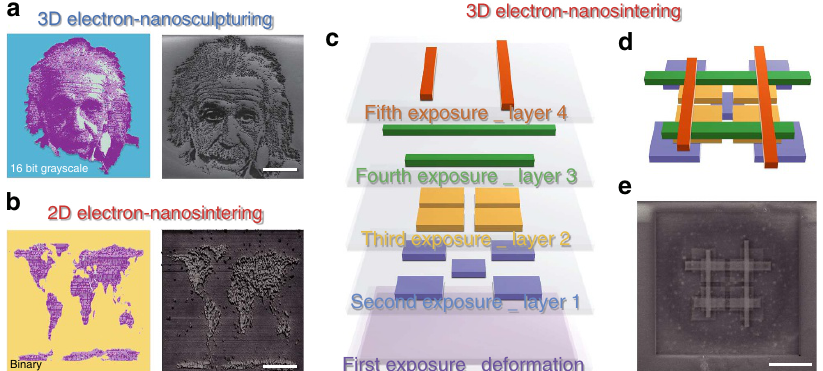
Figure 5 | 2D and 3D nanostructuring of silk proteins. ( a ) 3D electron-nanosculpturing: 3D nanotopographies on crystalline silk can be created using a 16-bit grayscale positive EBL (left: design image; right: SEM image). The Einstein image: Photo by Philippe Halsman @ Halsman Archive. One grayscale exposure was applied, followed by a water-only development to remove the exposed area. Scale bar, 10 m m. ( b ) 2D electron-nanosintering: 2D nanotopographies on amorphous silk proteins can be created using a binary negative EBL (left: design image; right: SEM image). Scale bar, 15 m m. One exposure was applied to crosslink the exposed area. Unexposed area is removed after water development. ( c ) 3D electron-nanosintering: 3D nanostructures on crystalline silk can be created using a LbL multi-EBL. Multiple exposures are applied in sequence to define each layer. The first exposure is to de-crosslink the crystalline silk proteins, resulting in amorphous proteins to be sintered/re-crosslinked by the following LbL EBL steps. For amorphous silk, this step (the first exposure) is unnecessary. ( d ) Schematic and ( e ) SEM images of as-designed 3D silk nanostructures using an LbL nanosintering process. Scale bar, 5 m